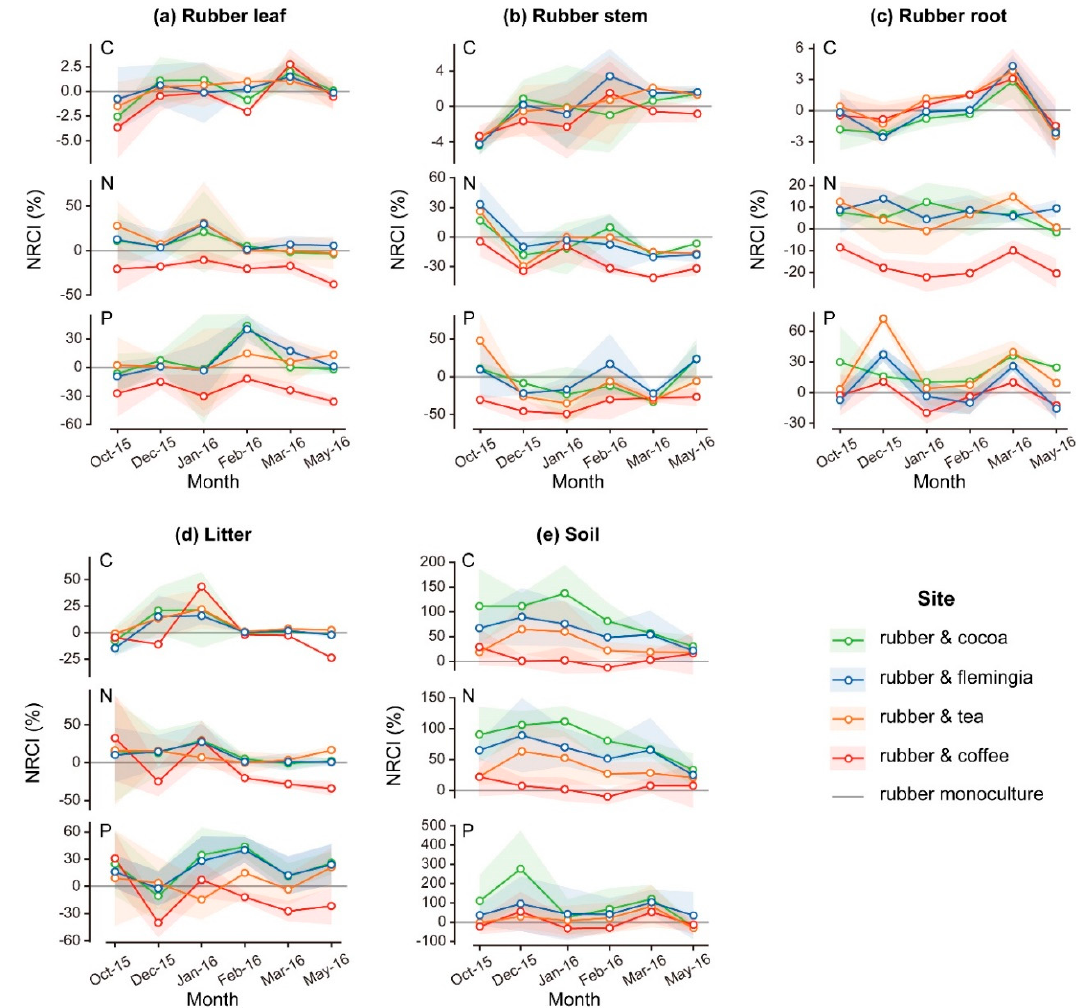
Figure 2. The negative relative competition intensity (NRCI) indexes of each agroforestry system (AFS), which were calculated through the carbon (C), nitrogen (N), and phosphorous (P) concentrations of ( a ) rubber leaves, ( b ) rubber stems, ( c ) rubber roots, ( d ) litter, and ( e ) soil. The shaded area indicates the 95% confidence interval.